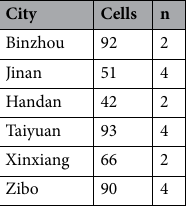
Table 3. Parameter training